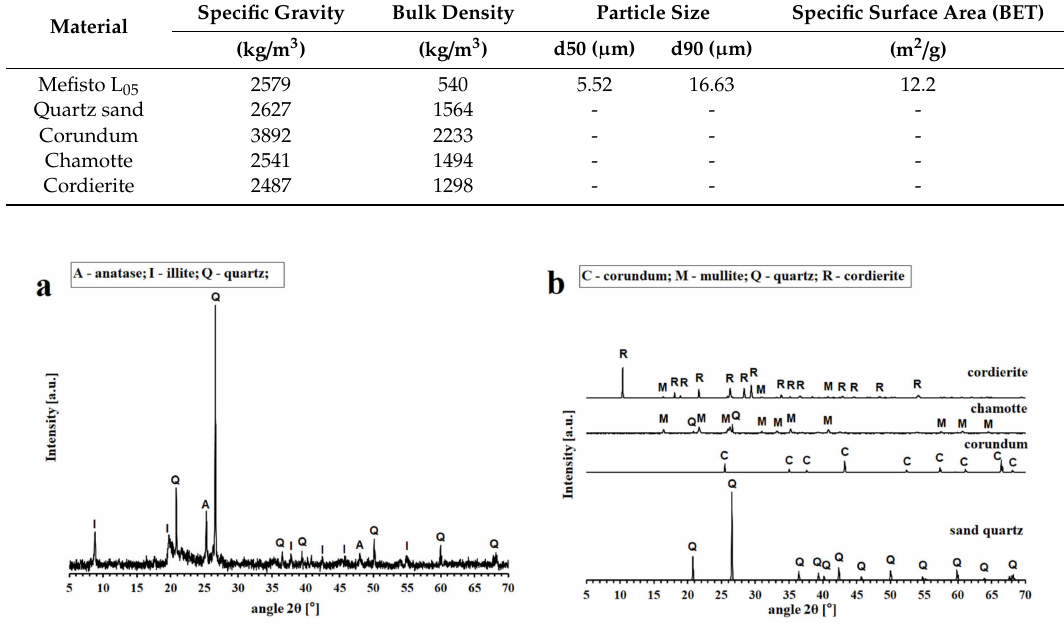
Table 2. Physical properties of raw materials.